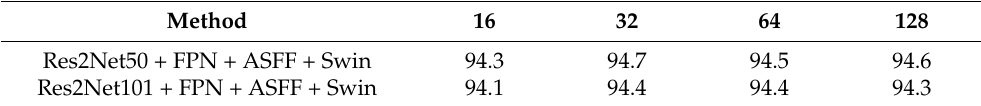
Table 5. The identification results of the improved method based on Res2Net50 and Res2Net101 under different batch sizes